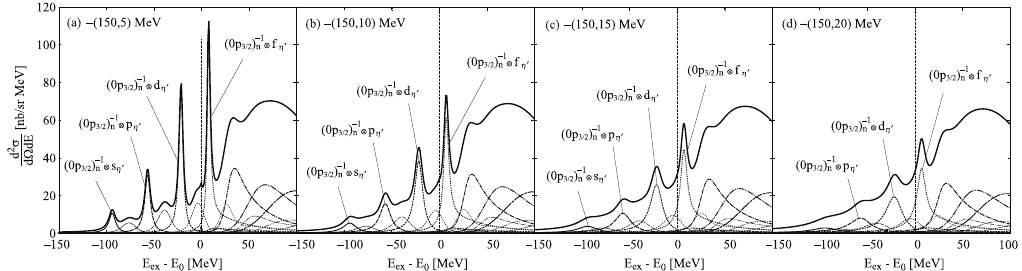
; W = (cid:0) (150 ; 5) MeV, (b) (cid:0) (150 ; 10) MeV, 0 0 ) and the (cid:17) 0 states as ‘ (cid:17) 0 . n